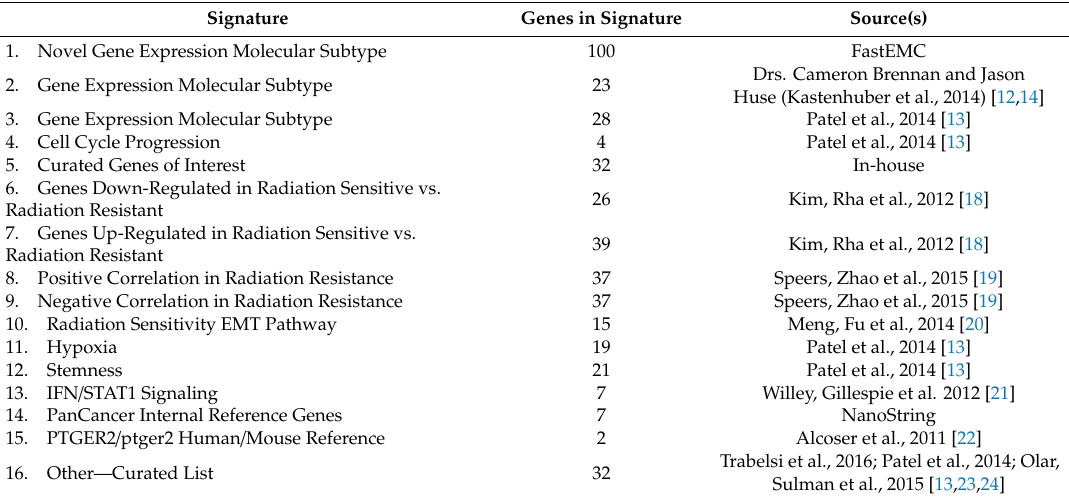
Table 1. List of gene signatures and their